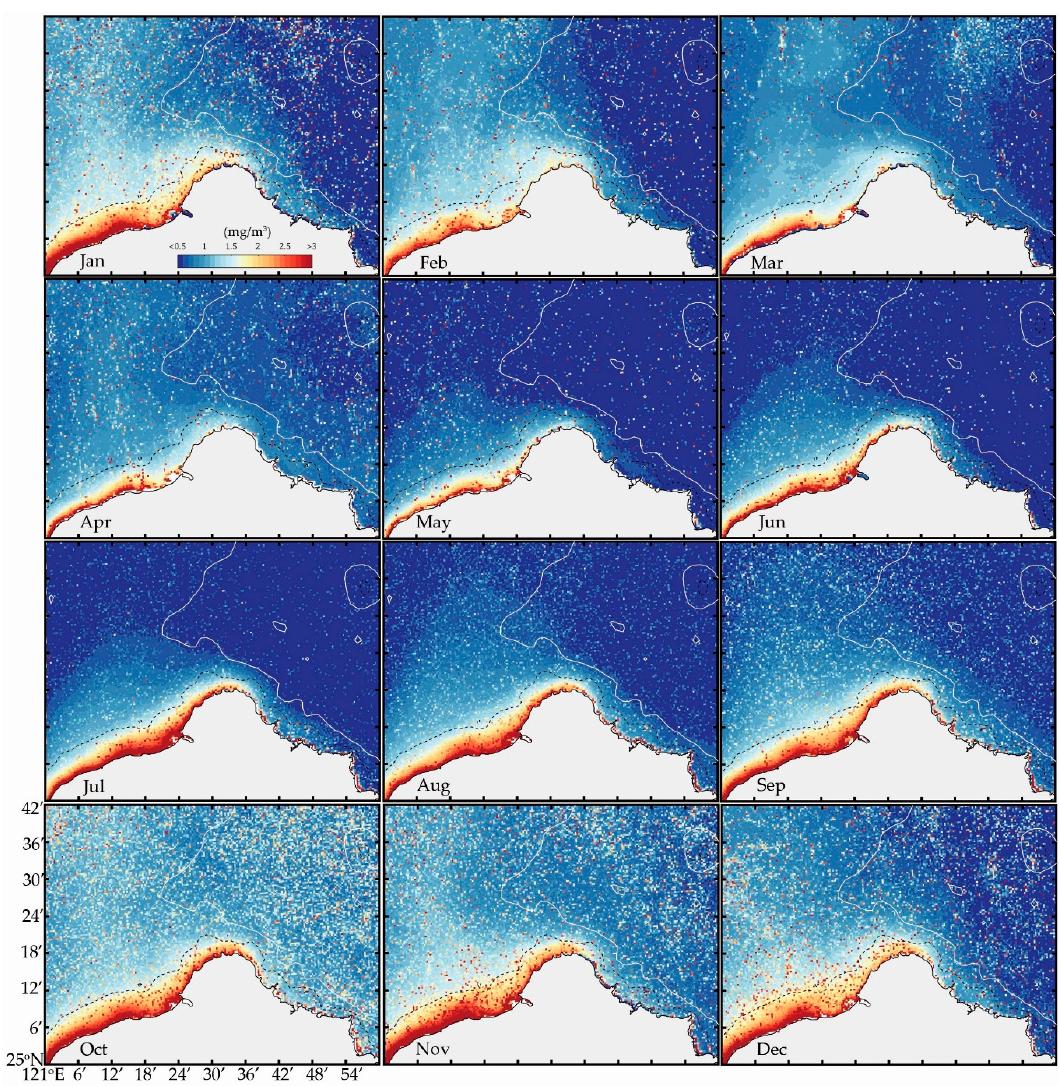
Figure 13. Distribution of the monthly average chlorophyll concentration from April 2011 to May 2020 along the northern coast of Taiwan. The black dotted lines and the white line segments represent the 50 m and 100 m isobaths, respectively.